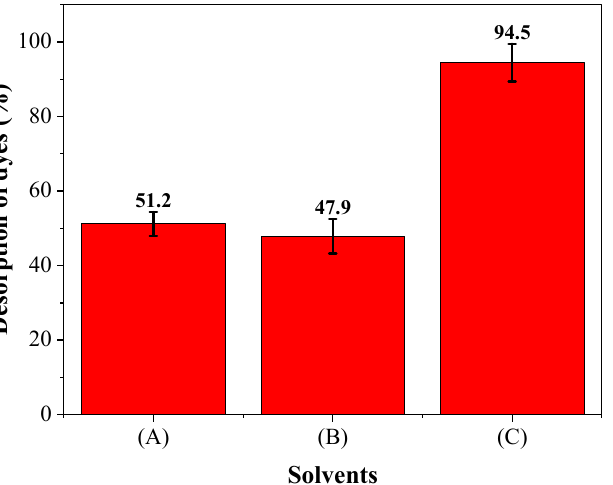
Figure 10. Regeneration of banana peel using different solvents: ( A ) 0.1 M HCl, ( B ) 0.1 M NaOH, and ( C ) subsequent addition of 0.1 M HCl and 0.1 M NaOH.